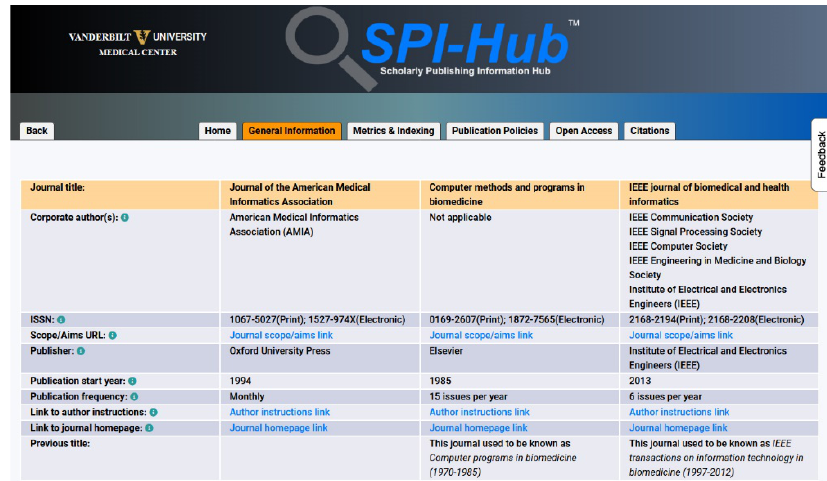
Figure 3 Example journal comparison